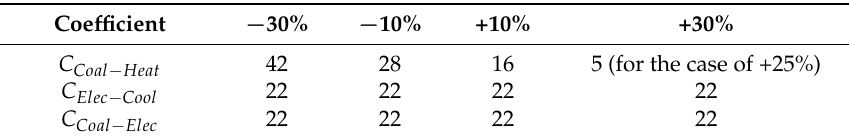
Table 10. Results of GHG emissions GRR for NG pathway compared with the conventional coal and public grid combined pathway under different coefficient assumptions (%). Coefficient − 30% +10%